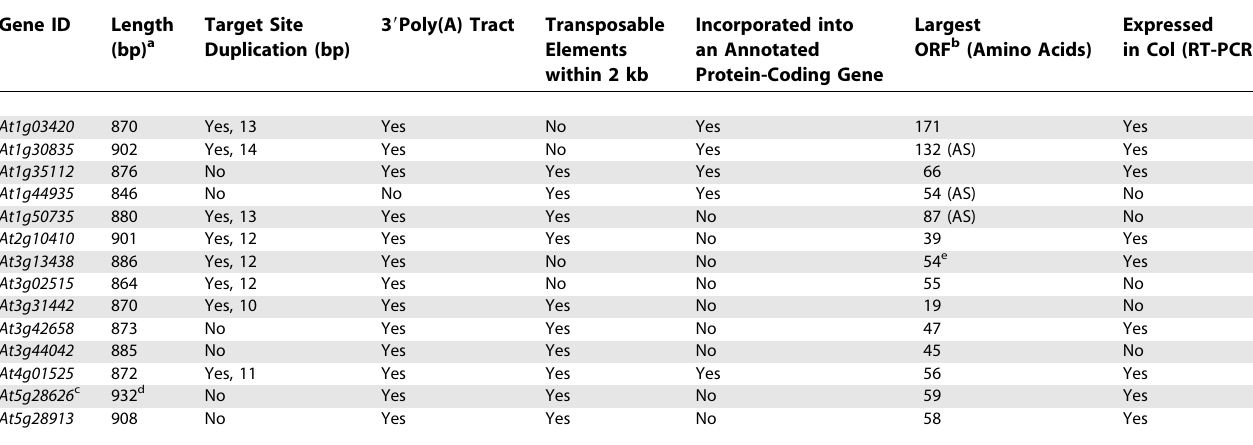
Table 3. Features of 14 Full-Length Members of the Sadhu Element Family in the Col Genome Gene ID Length (bp)